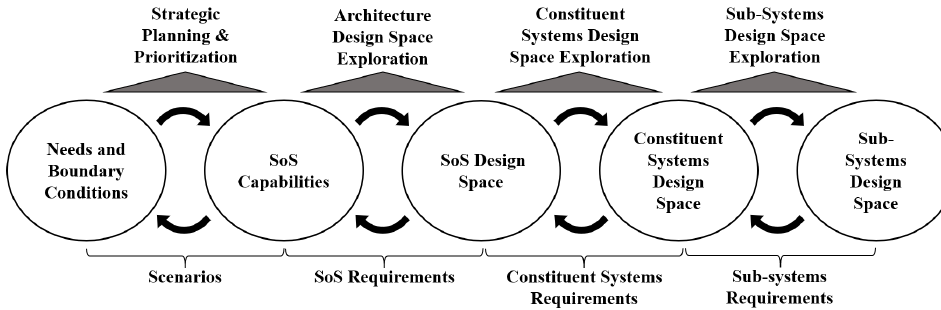
Figure 1. The holistic design process for a system of systems (SoS). Adapted from [5].